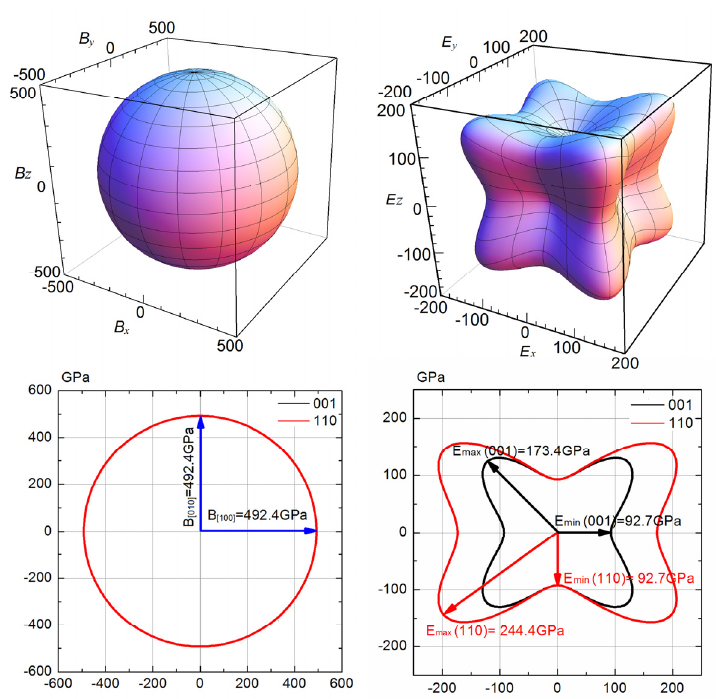
Figure 4. The surface constructions of the bulk modulus B and Young’s modulus E of AlNi 2 Ti; the corresponding planar projections of B on the [001] crystallographic plane and planar projections of E on [001] and [110] crystallographic planes are shown below.